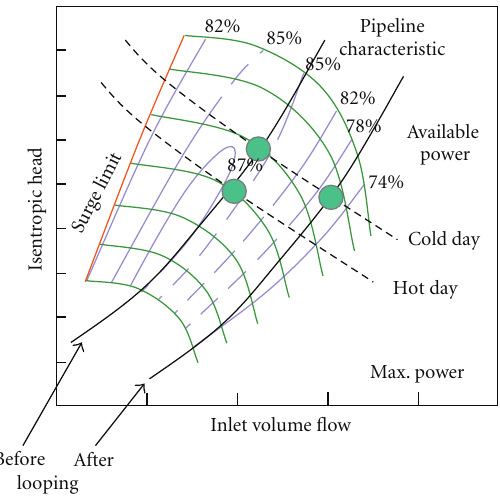
Figure 3: Operating point and driver power.